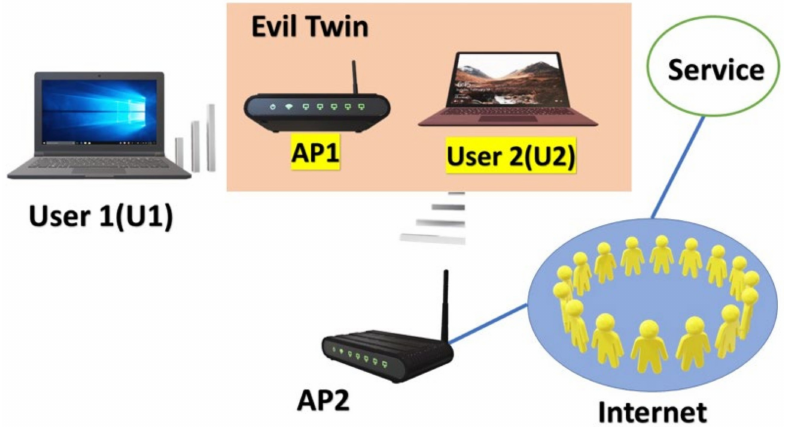
Figure 2. The perception of an Evil Twin by a WNIC (Wireless Network Interface